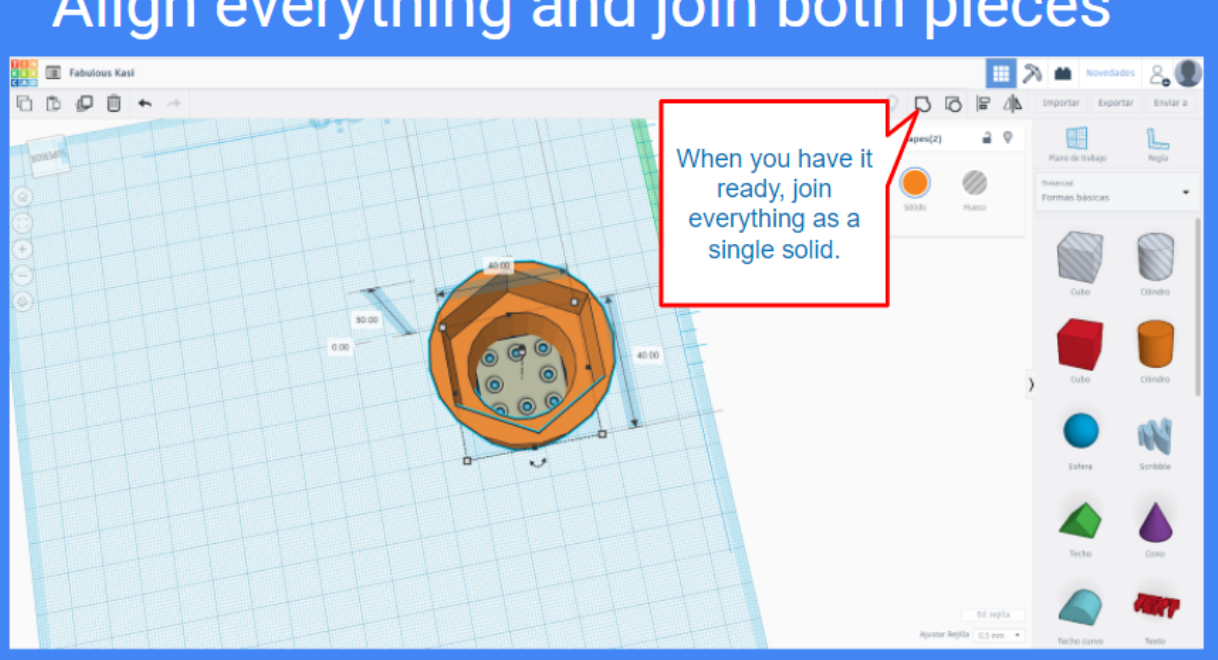
Figure 9. Tool designed by students to